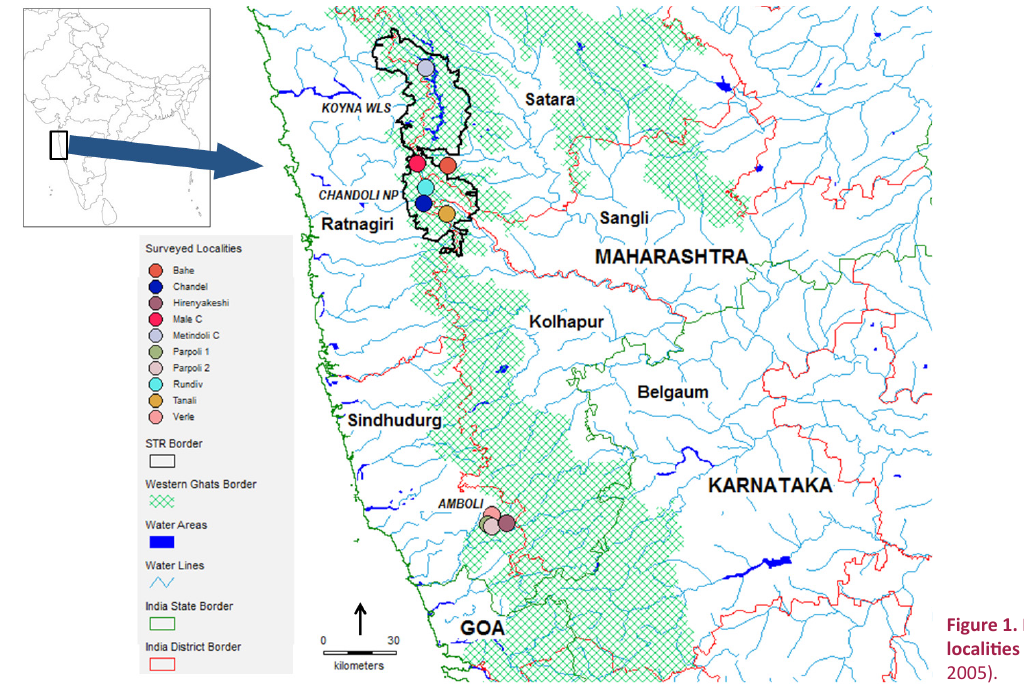
Figure 1. Map of study localities (Hijmans et al.